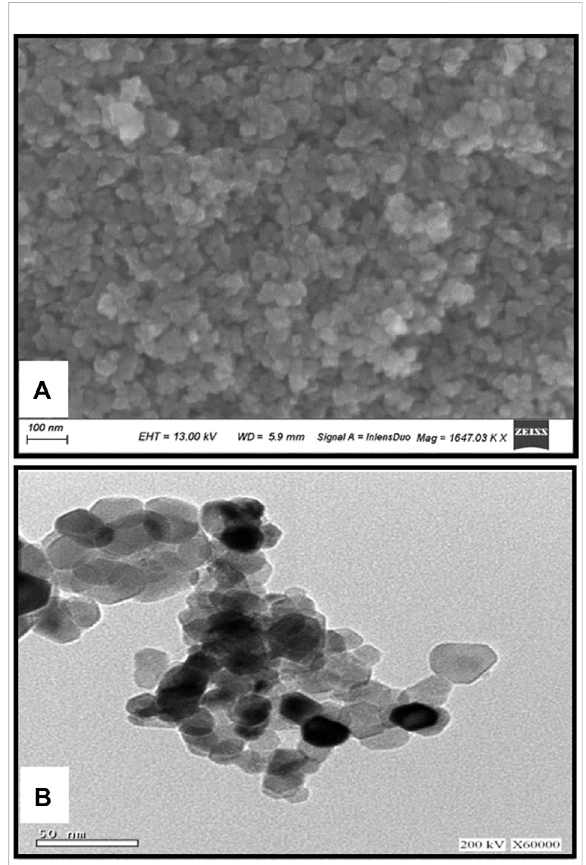
FIGURE 3 The XRD Difractogram (A) ; Transmition electron micrograph (B) ; Scanning electron photomicrograph of Nickel oxide nanoparticles. The XRD reveals the high crystalinity and purity of the prepared powder. The crystallite size is calculated automatically from the XRD softweare to be 42 nm which is con fi rmed visually from TEM and SEM photomicrographs (A,B)